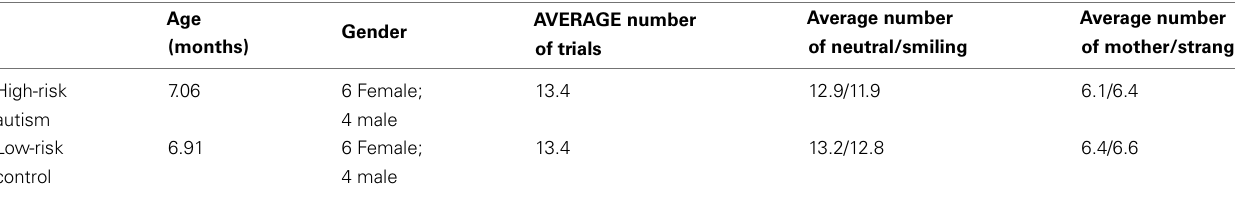
Table 2 | High-risk autism (HRA) group and low-risk controls